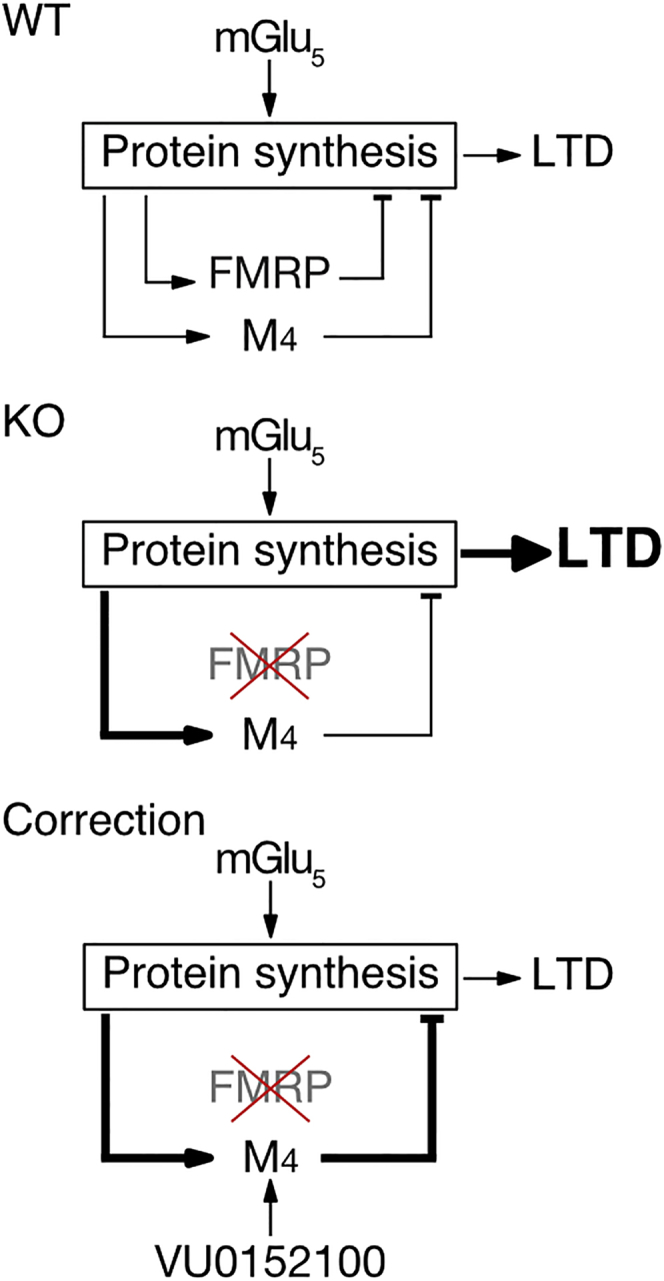
Potential Model for Correction of FX by M4 PAMOur results suggest a model whereby M4 is synthesized downstream of mGlu5 in order to negatively regulate protein synthesis and LTD, similar to FMRP. In FX, the absence of FMRP leads to the excessive synthesis of M4; however, this is unable to completely compensate for FMRP loss. By enhancing M4 with VU0152100, protein synthesis, LTD, and other pathological changes are normalized.